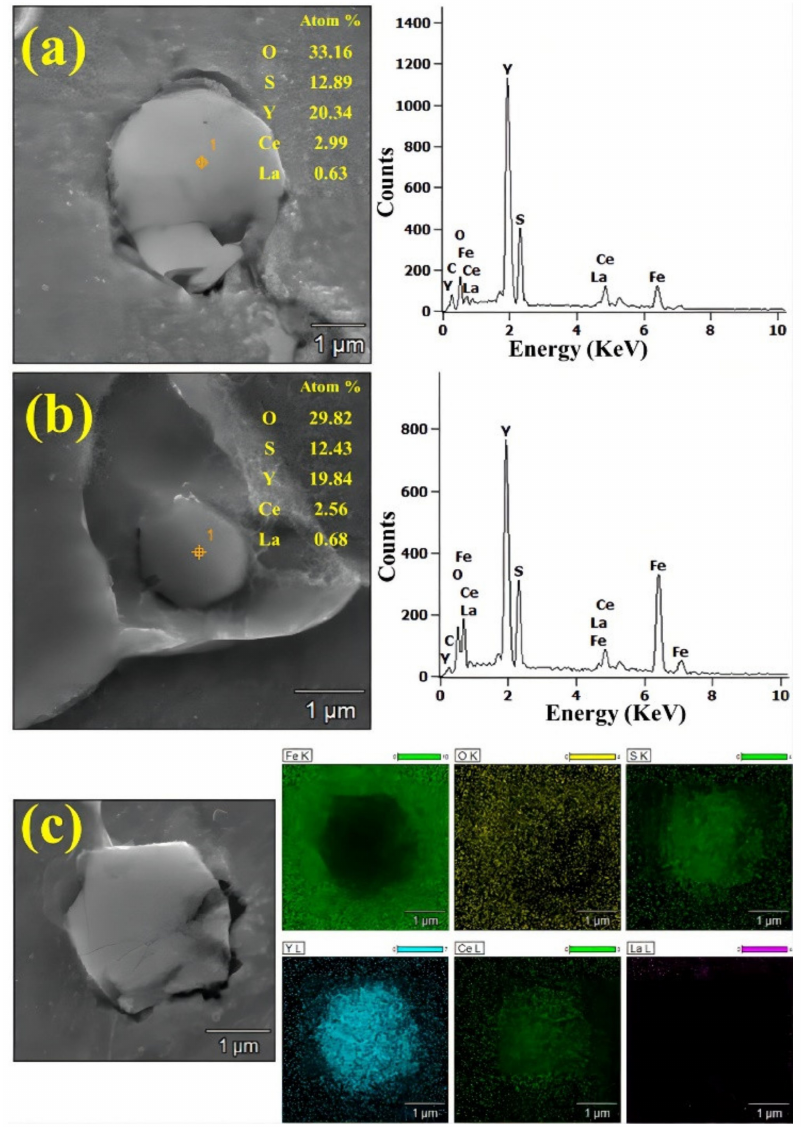
Figure 3. Morphology and type of ( a – c ) inclusions formed in 90RE